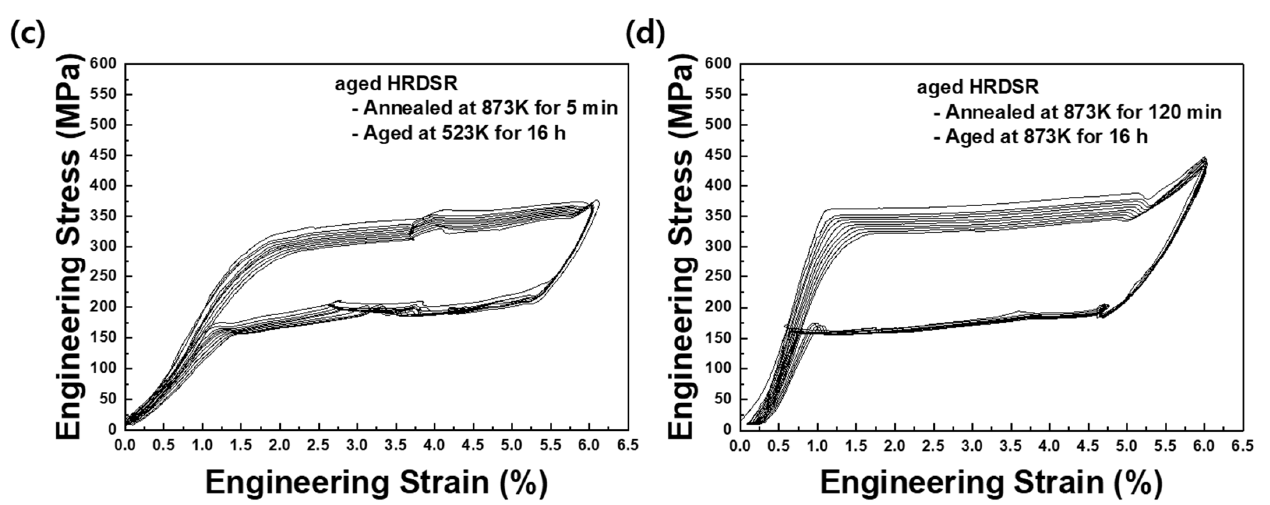
Figure 15. Superelastic cyclic tests up to the strain of 6% for ( a ) the aged AR sample (after annealing at 873 K for 5 min), ( b ) the aged AR sample (after annealing at 873 K for 120 min), ( c ) the aged HRDSR sample (after annealing at 873 K for 5 min) and ( d ) the aged HRDSR sample (after annealing at 873 K for 120 min).